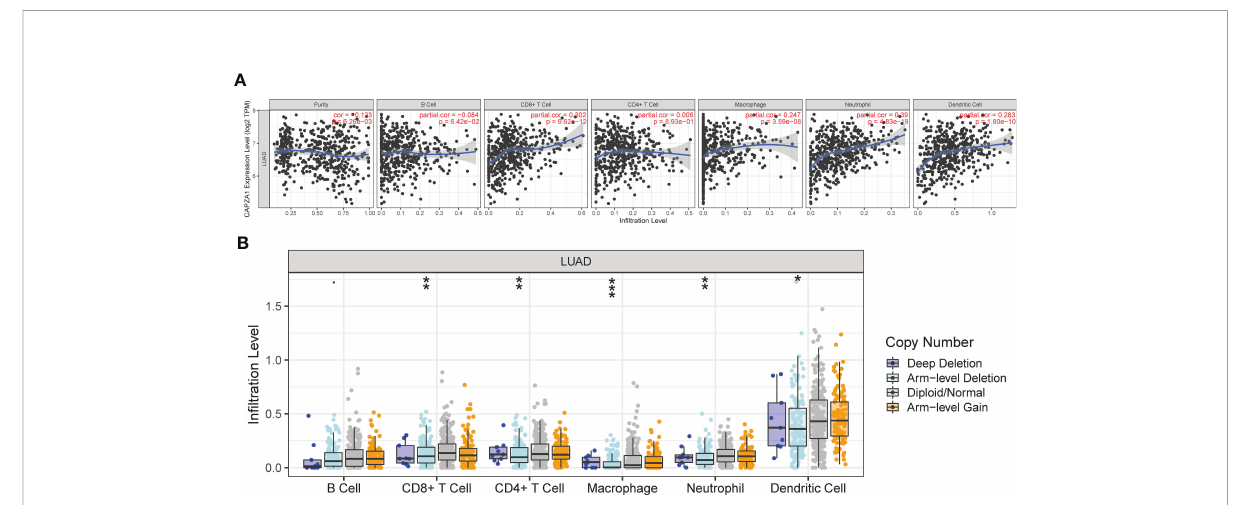
FIGURE 7 The relationship of immune cell in fi ltration with CAPZA1 level in LUAD. (A) The correlation of CAPZA1 expression level with B cell, CD8+ T cell, CD4+ T cell, macrophage, neutrophil, or dendritic cell in fi ltration level in LUAD. (B) The in fi ltration level of various immune cells under different copy numbers of CAPZA1 in LUAD. *p-value < 0.05; **p-value < 0.01; ***p-value <